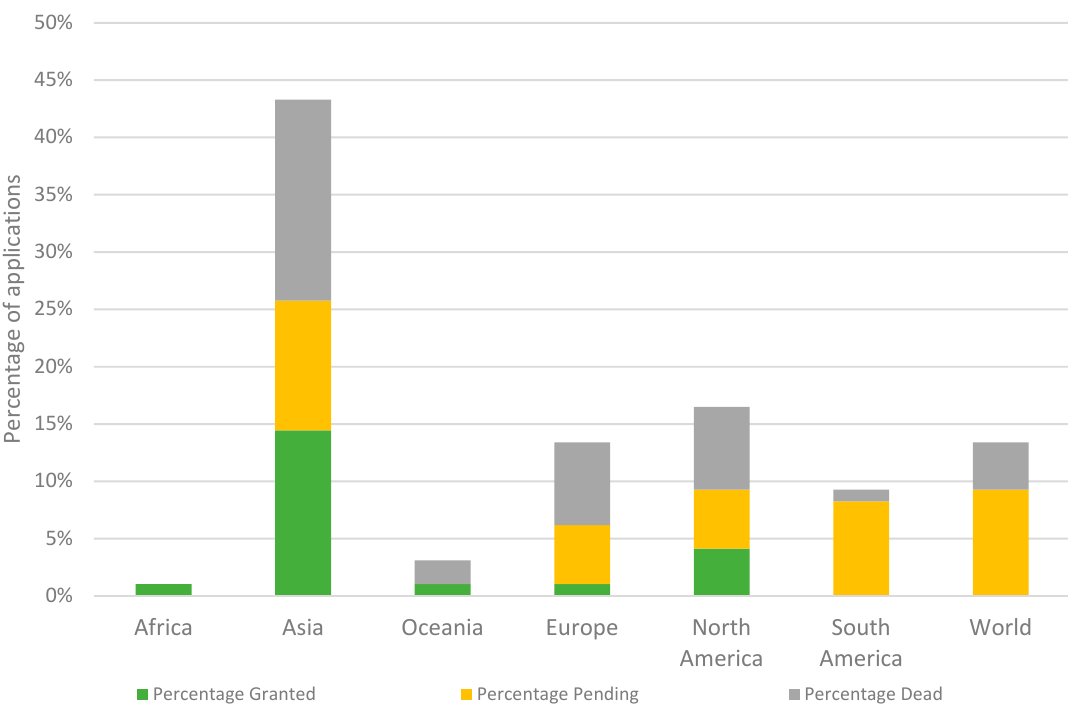
Figure 2. Percentage of patents and applications organized per continent. The total height of the bars indicate the percentage of patents and applications per continent. Africa (ZA), Asia (CN, IN, JP, KR), Oceania (AU, NZ), Europe (DE, EA, EP, ES, GB, IT), North America (CA, US), South America (AR, BR, CL, CR, GT, MX, PE), and world applications. In green, the percentage of granted patents; in yellow, the percentage of pending applications; and in grey, the percentage of dead applications and dead patents.